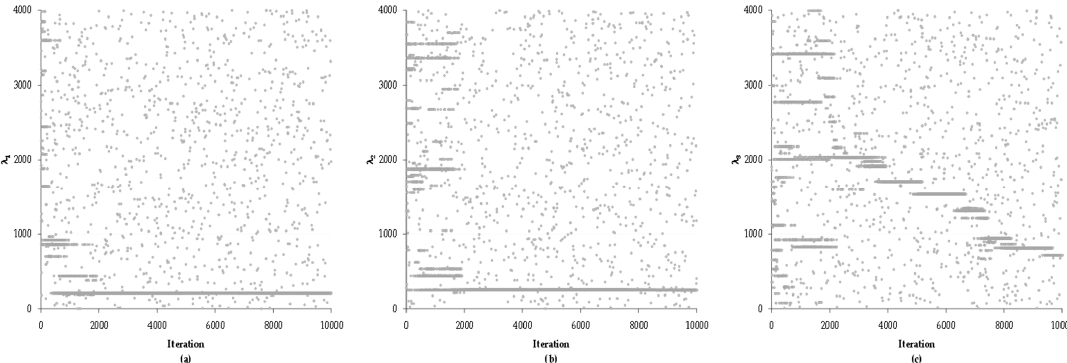
( b ) ε 2 ; and ( c ) ε 3 for hydrometric station 10031.